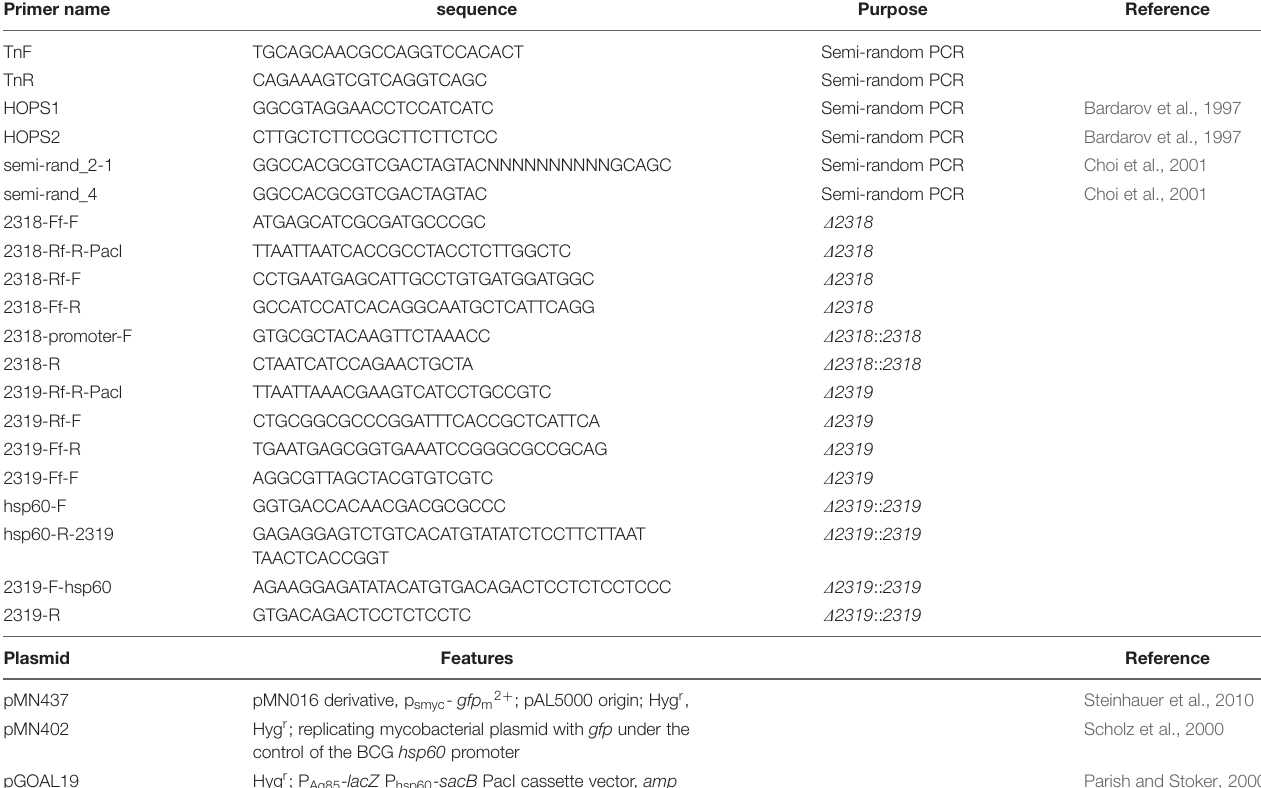
TABLE 1 | Primers and plasmids used in this